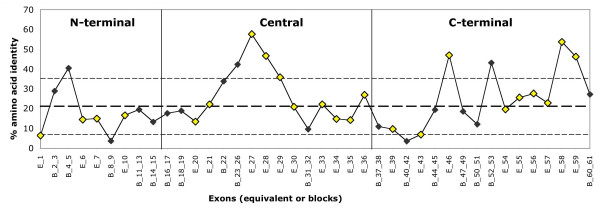
Percentage amino acid identity calculated for each Equivalent exon (E, in yellow) and exon-Block (B, in gray). The percentage amino acid identity was calculated from the chordate protein alignment for each of the equivalent exons and exon-blocks described in Figure 1. Numbers refer to the Ciona exon numbering. Bold-dashed line represents the mean % identity (21.2%) calculated over the entire alignment length. Normal-dashed lines represent mean value +/- standard deviation (7.1).